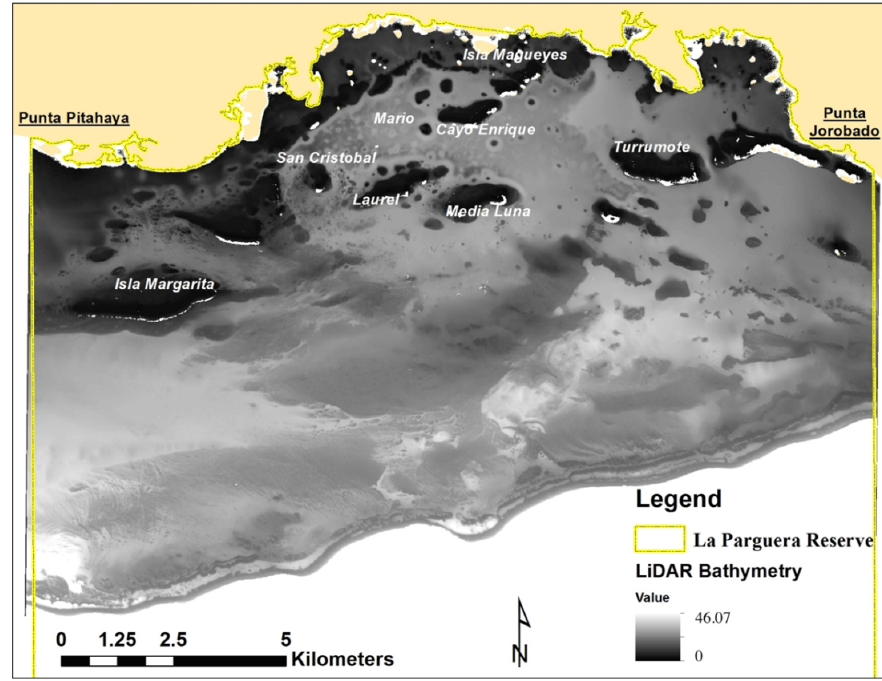
Figure 2. LiDAR bathymetry image, subset of La Parguera Reserve.